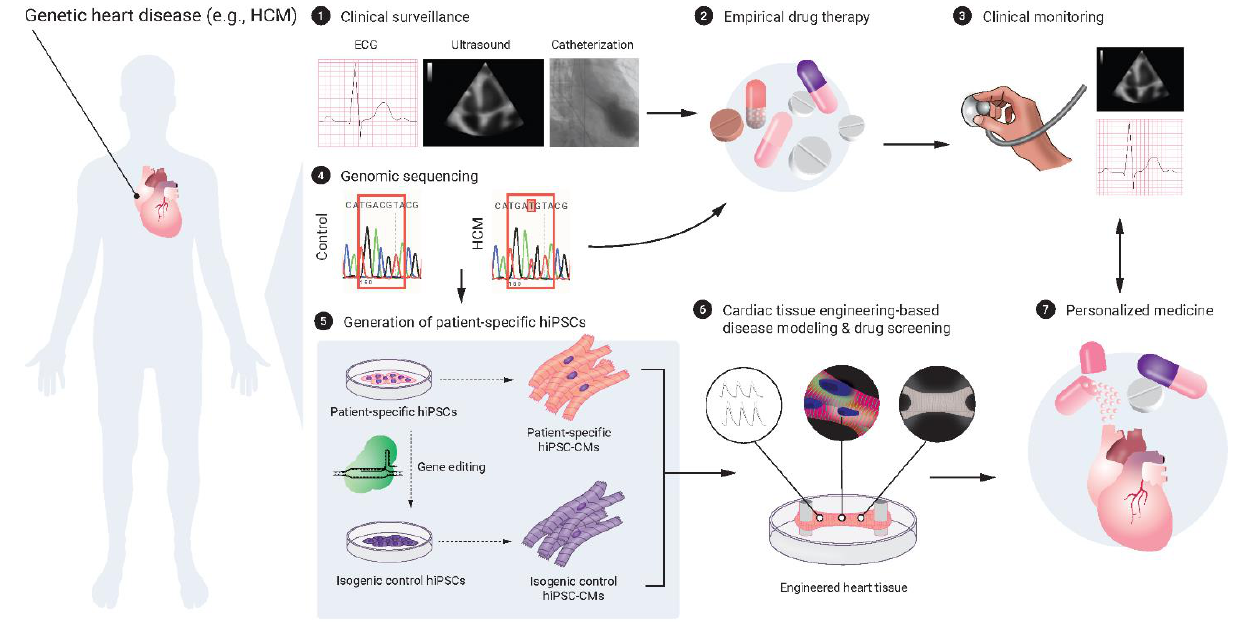
Figure 2. Modeling of cardiac tissue engineering-based personalized medicine for genetic heart disease. The panel highlights the hPSC-CM and 3D engineered heart tissue-combined platforms for